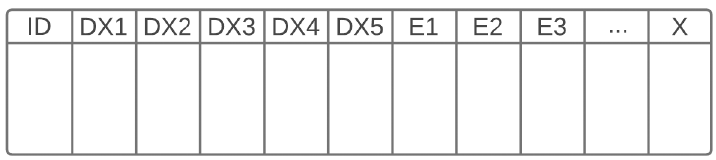
Figure 3: Example study data set